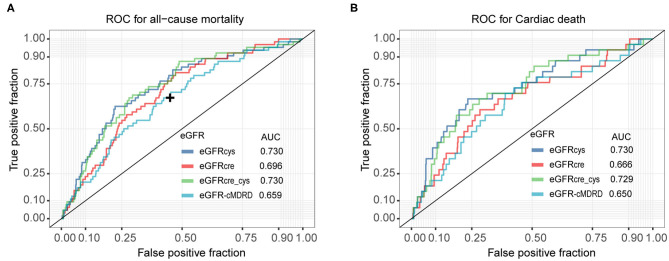
ROC for predicting all-cause mortality and cardiac death. (A), accuracies of eGFRcys, eGFRcre, eGFRcre-cys, and eGFR-cMRDR for predicting all-cause mortality presented as areas under the receiver operating characteristic curves, individually. (B), accuracies of eGFRcys, eGFRcre, eGFRcre-cys, and eGFR-cMRDR for predicting cardiac death presented as areas under the receiver operating characteristic curves, separately. ROC, receiver operating characteristic curve; AUC, area under the receiver operating characteristic curve. DeLong's test to check the difference of AUC for eGFRs calculated by other formulas, compared to eGFRcys. + represents significant differences (P < 0.05).